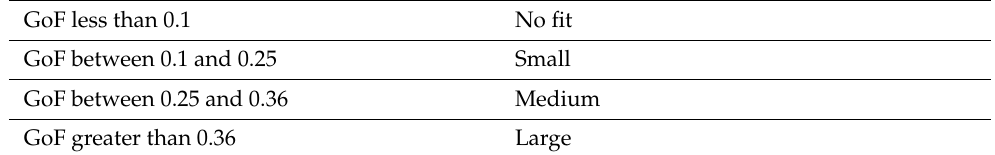
Table 11. Value of goodness of fit of the model (GoF). GoF less than 0.1 No fit GoF between 0.1 and 0.25 Small GoF between 0.25 and 0.36 Medium GoF greater than 0.36